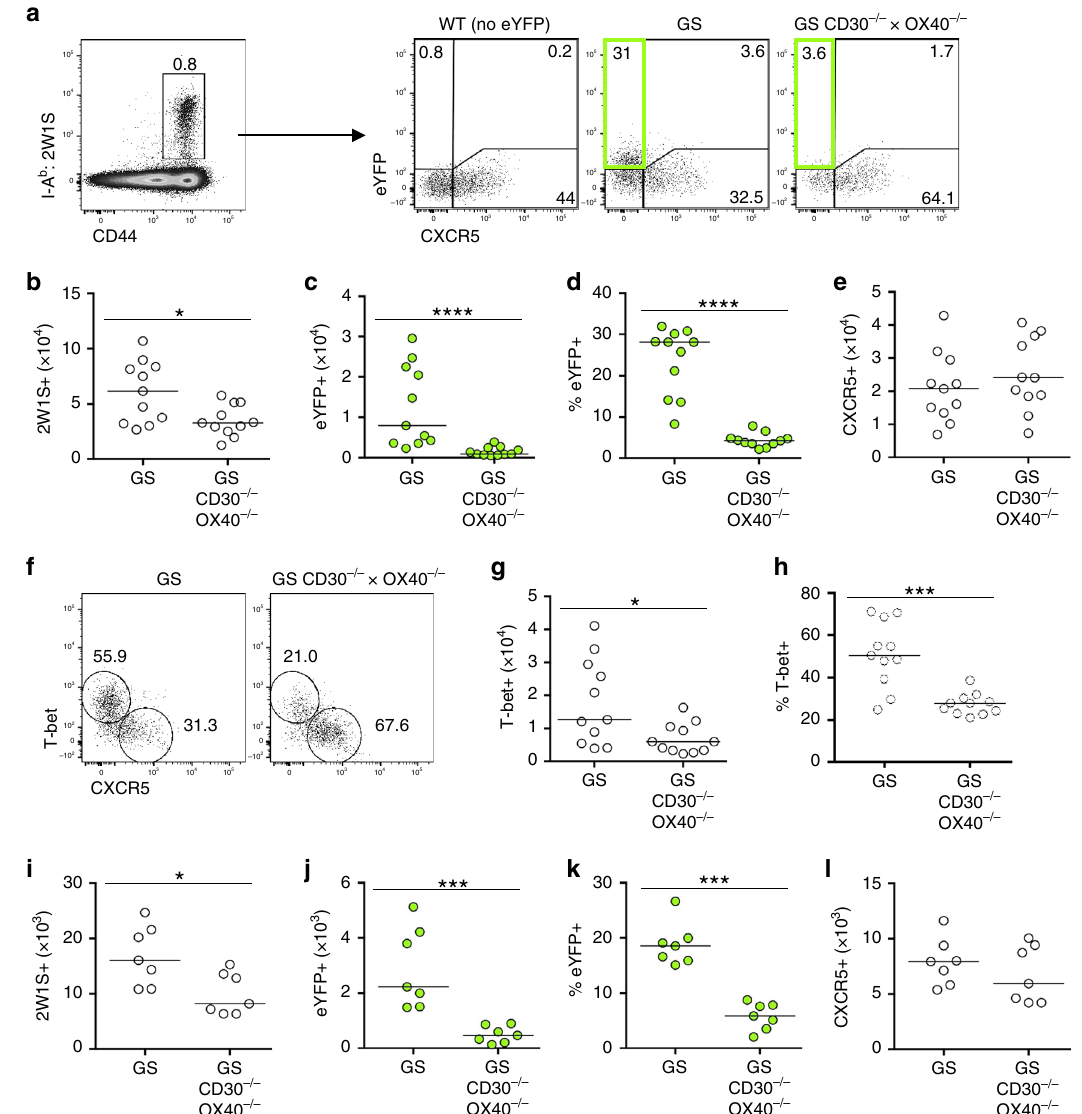
Fig. 1 Mice de fi cient in CD30 and OX40 show a dramatic decrease in reporting of IFN γ production. To determine the requirement for CD30 and OX40 on CD4 T cell effector function without ex vivo manipulation, dual IFN γ (eYFP) and IL-17A reporter mice (Great × Smart17A, GS) suf fi cient or de fi cient in CD30 and OX40 (GS CD30 − / − × OX40 − / − ) were infected i.v. with Lm -2W1S and the splenic response analysed at 7 ( a – h ) and 4 ( i – l ) dpi. a Gating strategy showing identi fi cation of 2W1S-speci fi c CD44 hi CD4 T cells and their expression of CXCR5 and eYFP in GS and GS CD30 − / − × OX40 − / − mice.